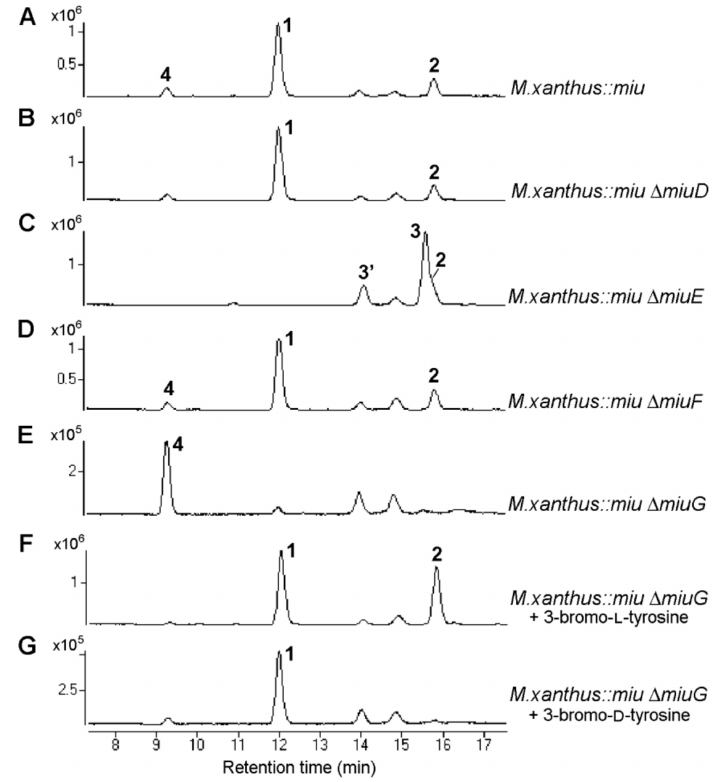
Figure 4. Production of miuraenamide A ( 1 ) and its congeners via four heterologous mutants lacking miuD–G . Extracted ion chromatographs (merged from m/z 684.2216, 606.3125, 656.2285, 670.2068, and 672.2217) of the extracts of the heterologous producer without gene disruption M. xanthus :: miu ( A ), miuD (cytochrome P450 gene)-disrupted mutant M. xanthus :: miu ∆ miuD ( B ), miuE ( O -methyltransferase gene)-disrupted mutant M. xanthus :: miu ∆ miuE ( C ), miuF (thioesterase gene)-disrupted mutant M. xanthus :: miu ∆ miuF ( D ), miuG (halogenase gene)-disrupted mutant M. xanthus :: miu ∆ miuG ( E ), M. xanthus :: miu ∆ miuG fed on 3-bromo-L-tyrosine ( F ), and M. xanthus :: miu ∆ miuG fed on 3-bromo-D-tyrosine ( G